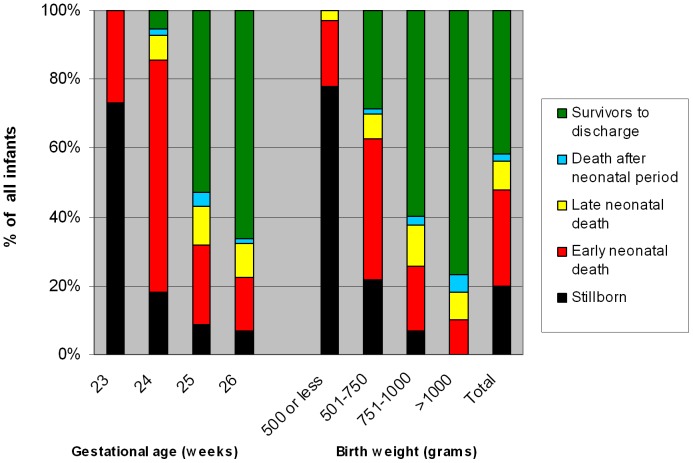
Mortality of all infants born (n = 345) in the Netherlands between January 1, 2007 and December 31, 2007 by gestational age (weeks) and birth weight (grams).